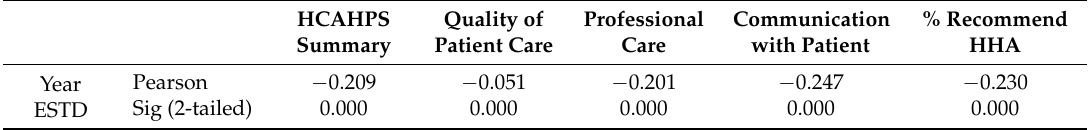
Table 2. Relationship of the year of HHA establishment with the five star ratings under